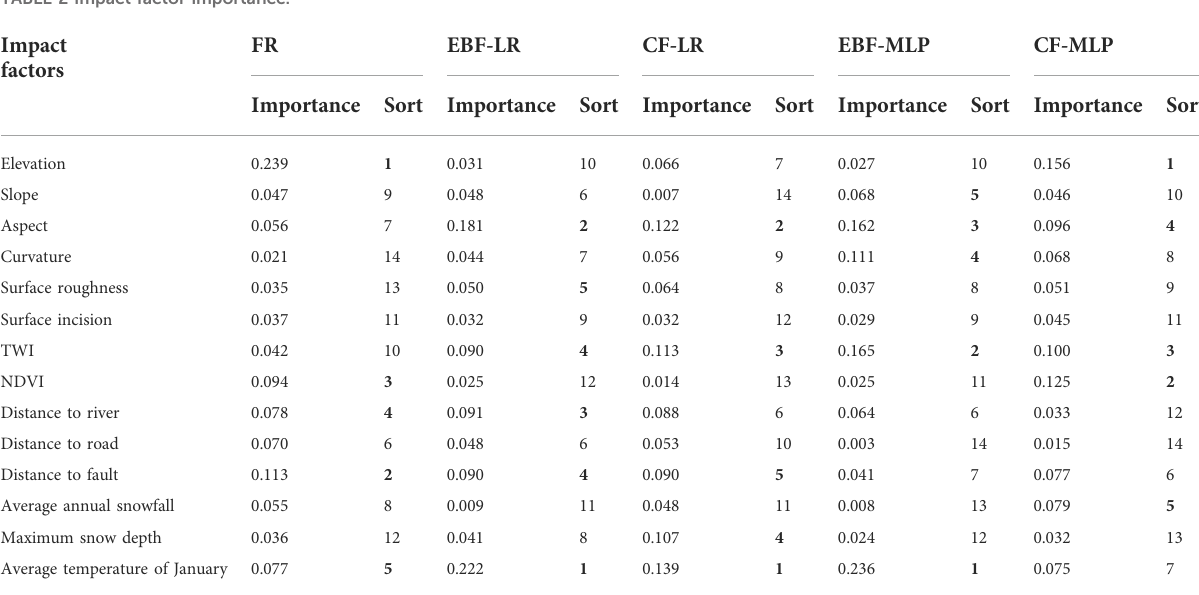
TABLE 2 Impact factor